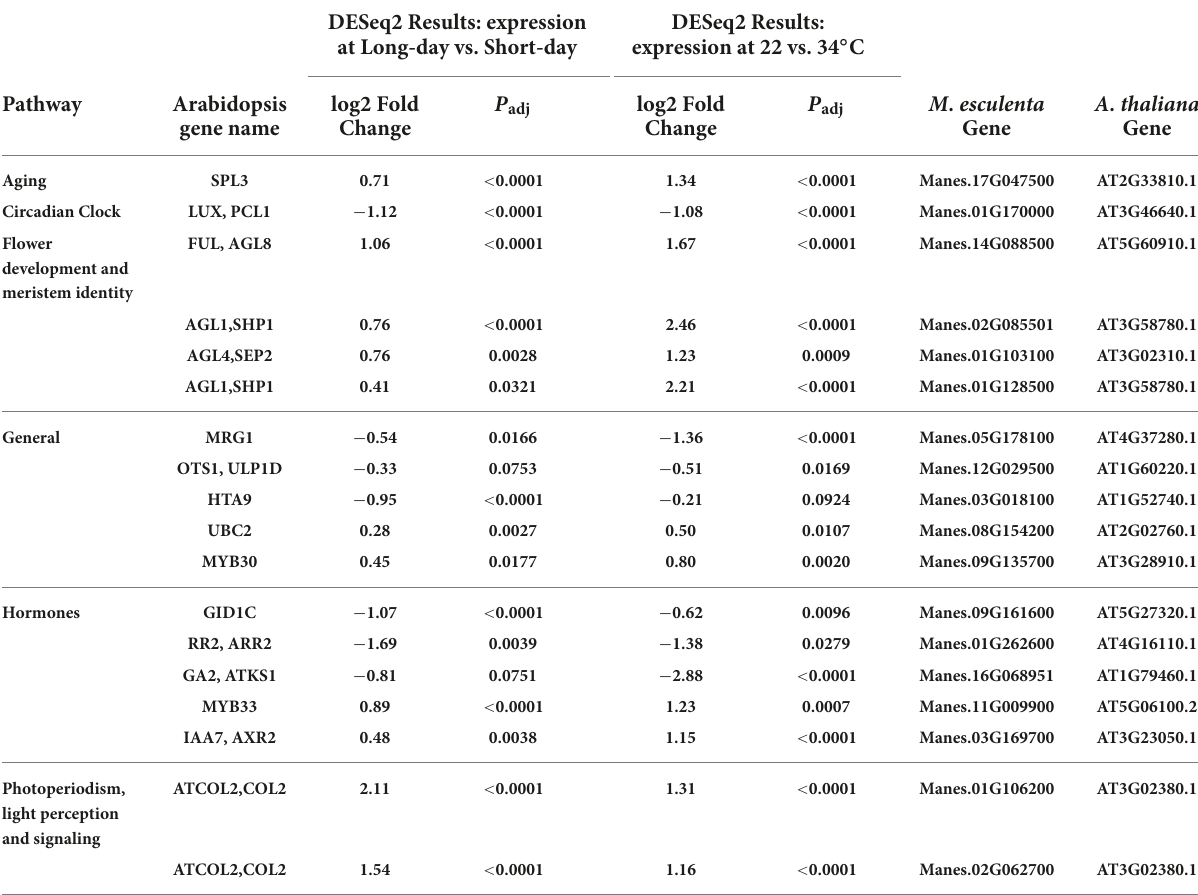
TABLE 5 Significant differentially expressed genes (DEGs) and log2 Fold Change from flowering pathways that where identified in both photoperiod and temperature induction of flowering in cassava. DESeq2 Results: expression DESeq2 Results: at Long-day vs. Short-day expression at 22 vs. 34 ◦